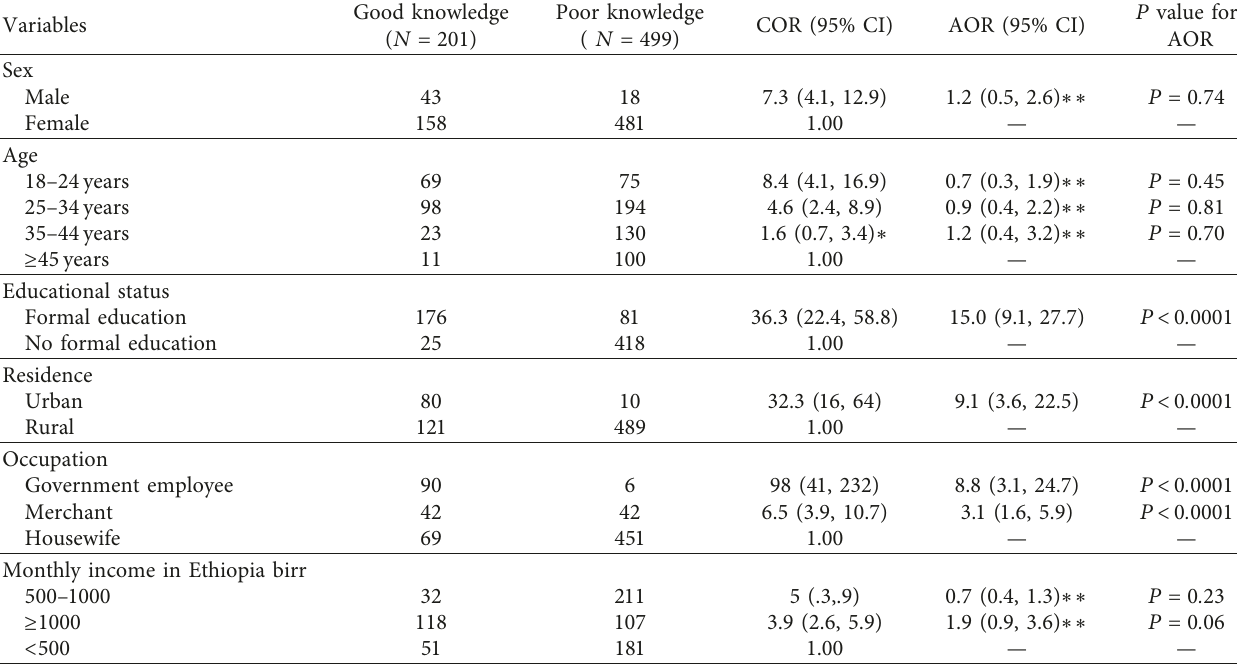
Table 4: Factors associated with knowledge on use of iodized salt at the household level in the Mecha district, Western Amhara, Ethiopia, 2018 ( N �